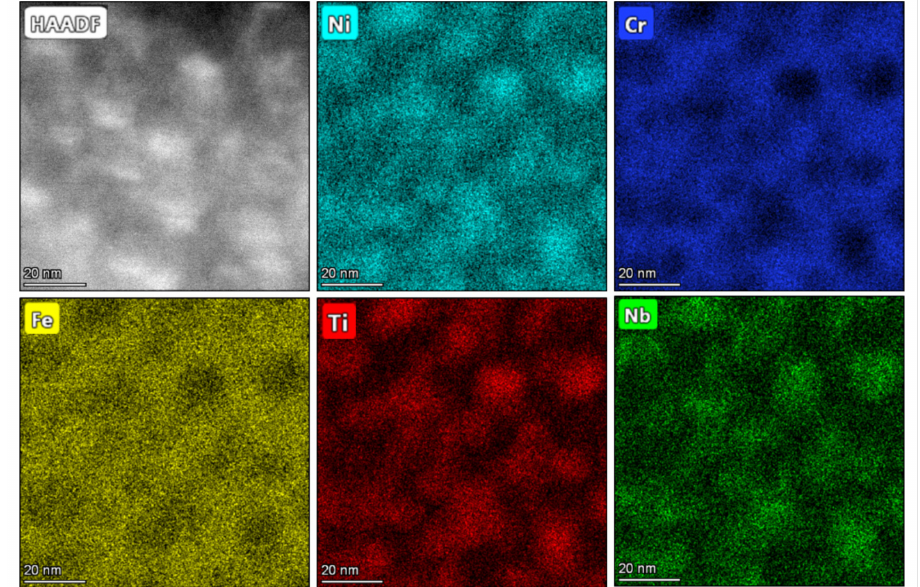
Figure 5. The HAADF-STEM image and the EDS mapping distribution of γ (cid:48) phase in the 945A-32h